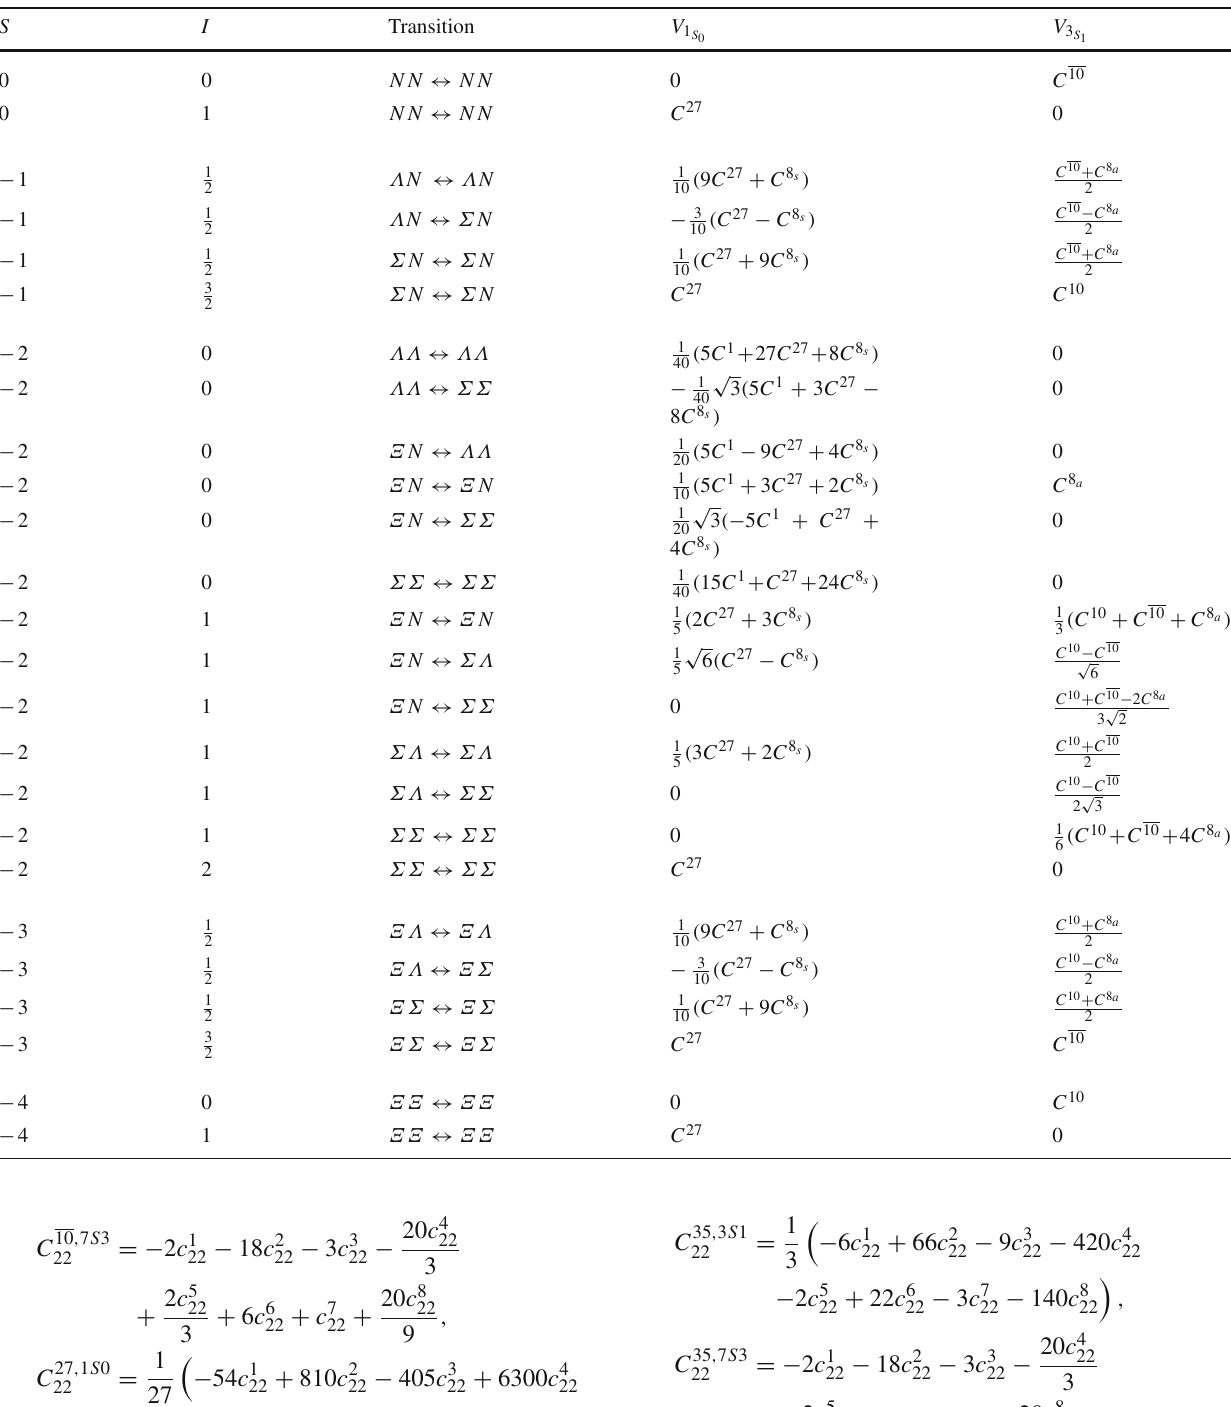
that denotes the BB channel is 00